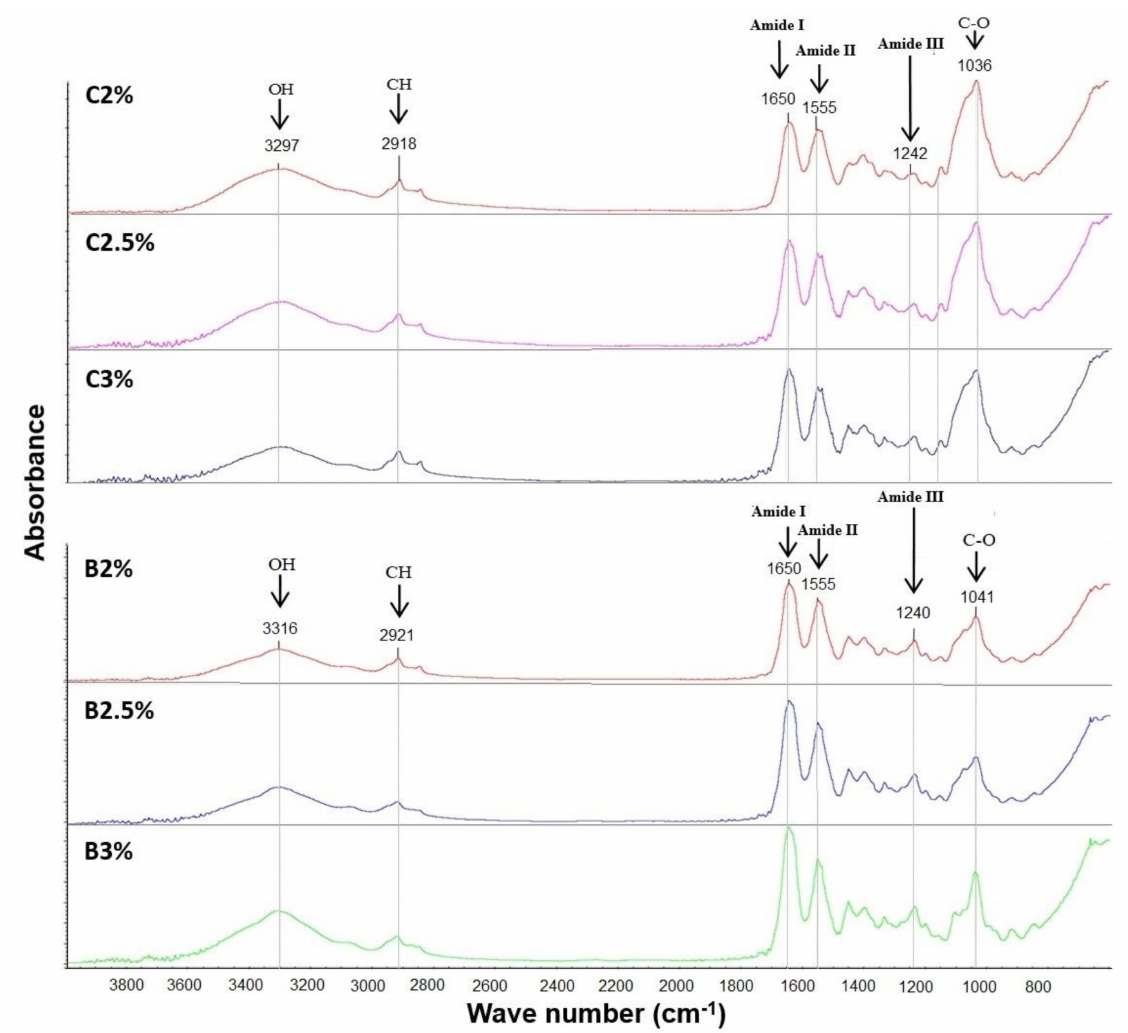
Figure 2. FTIR spectra of composite and bilayer